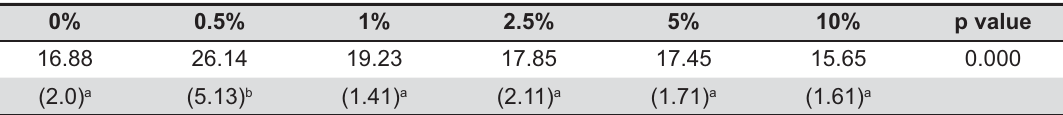
Table 4- Mean standard deviation (SD) of surface hardness of self-cured acrylic resin incorporated with different percentages of nanostructured silver vanadate